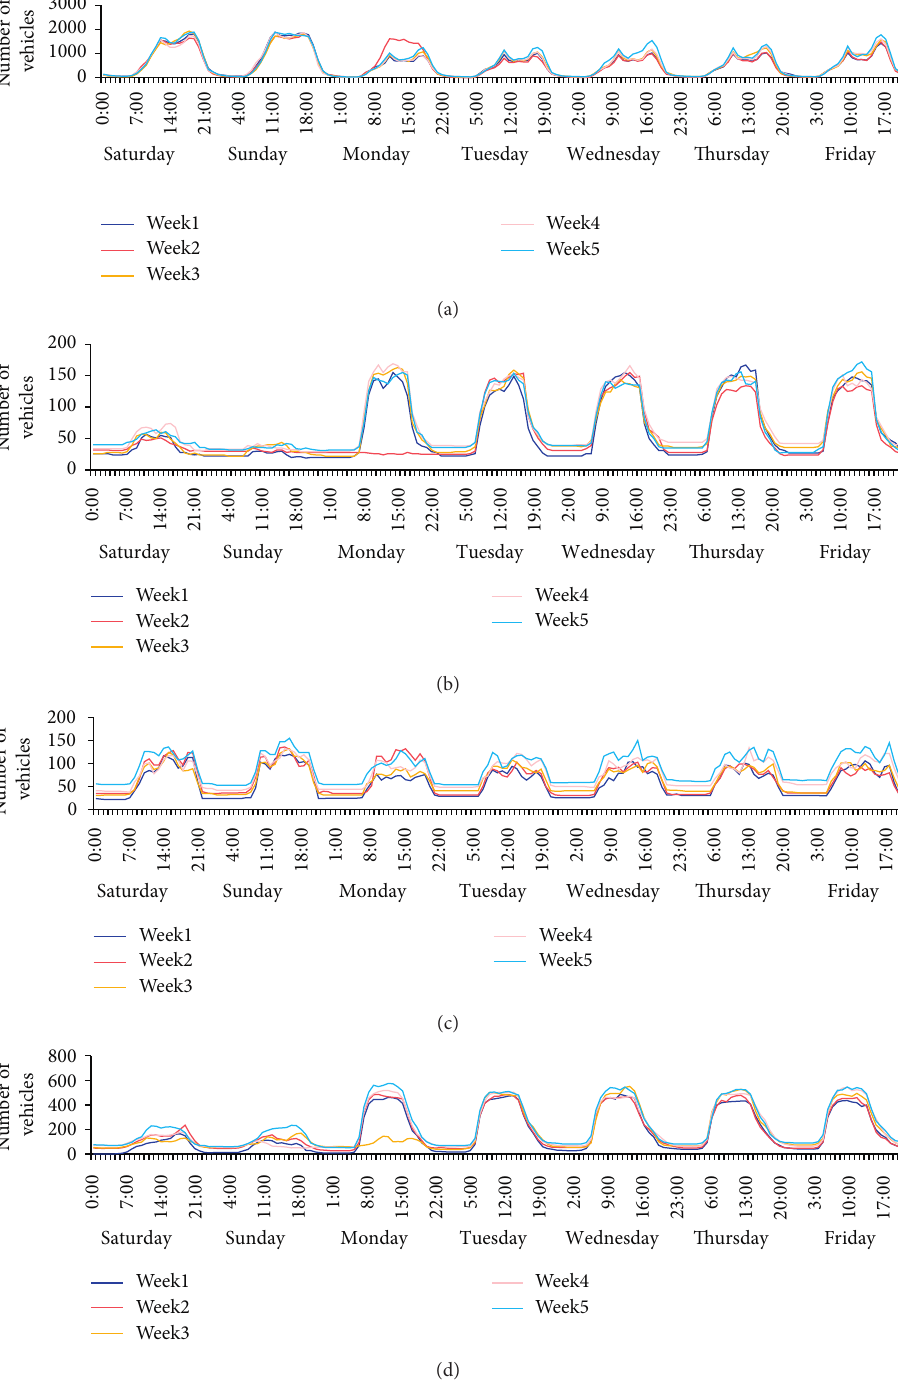
Figure 2: Parking curve of (a) parking lot 1, (b) parking lot 2, (c) parking lot 3, and (d) parking lot